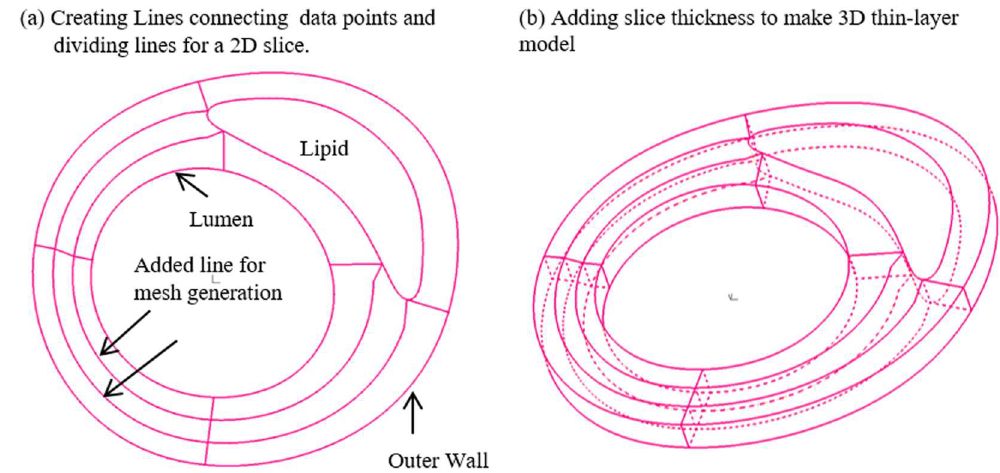
Fig 3. 3D thin-layer model construction. (a) Creating Lines connectingdata points and dividinglines for a 2D slice; (b) Addingslice thickness to make 3D thin-layer model.